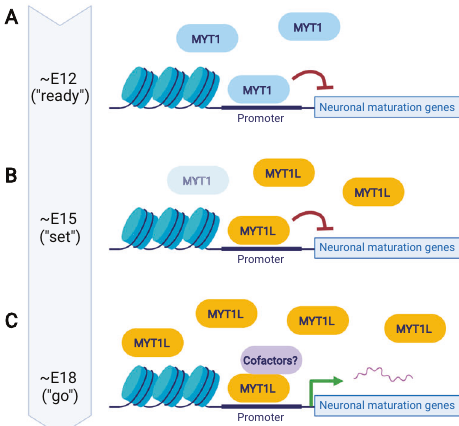
Fig. 3 Speculative “ ready-set-go ” model of MYT TFs during neuronal differentiation. A “ Ready ” phase: initial expression of MYT1 during early neurodevelopment represses non-neuronal and neuronal maturation gene expression programs. B “ Set ” phase: MYT1 expression fades and is replaced by MYT1L and is still net repressive to prevent maturation gene expression. This ensures maintenance of the progenitor pool. C “ Go ” phase: MYT1L, due to possible interactions with cofactors, postransciptional modi fi cations, or increased expression levels activates the expression of neuronal maturation genes. Figure created with